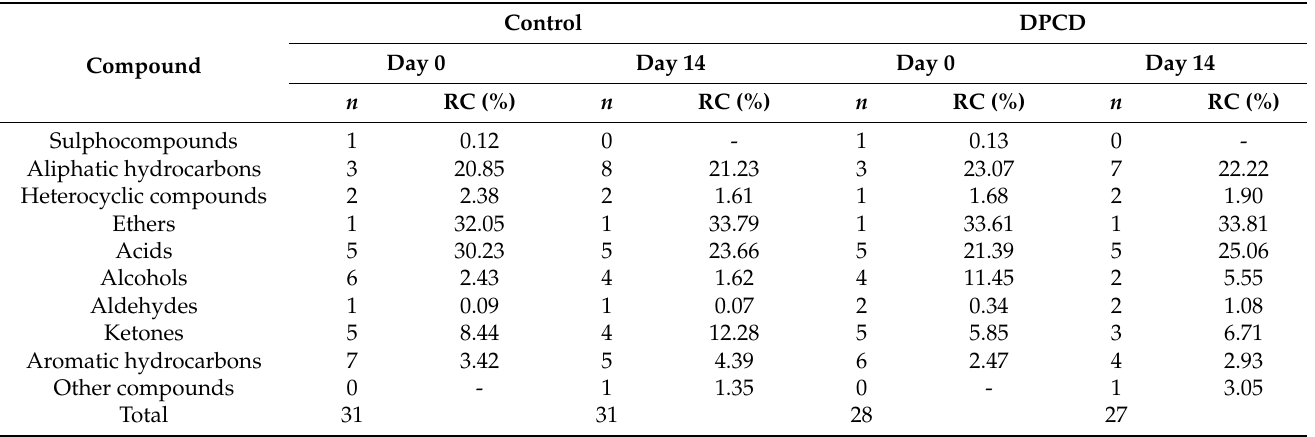
Table 6. Quantity and relative contents of volatile compounds of control and dense-phase carbon dioxide (DPCD)-processed cheese stored at 4 ◦